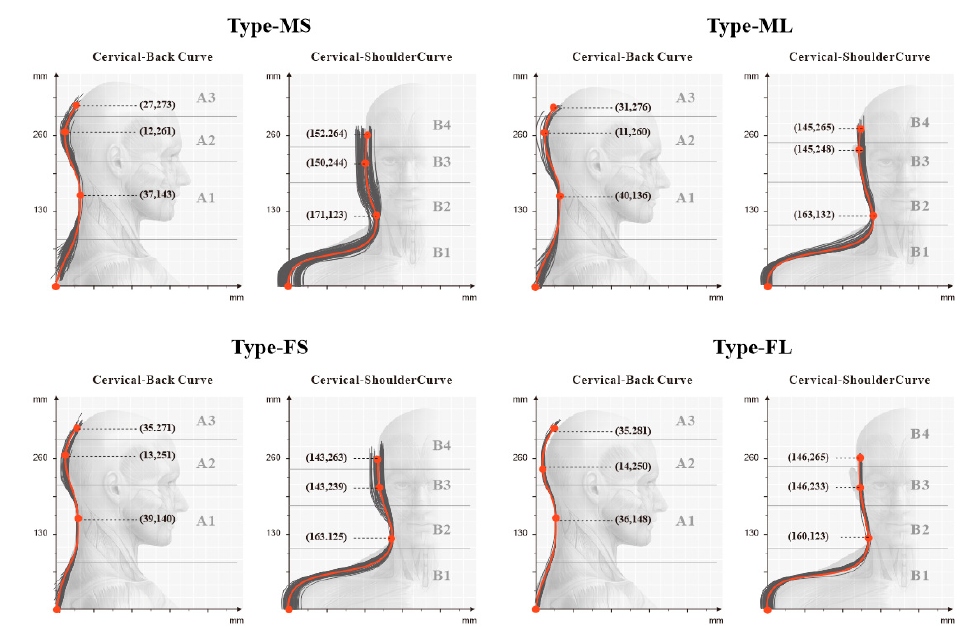
Figure 6. The median coordinates of the ergonomic nodes of the head and neck contours of the four groups of people.